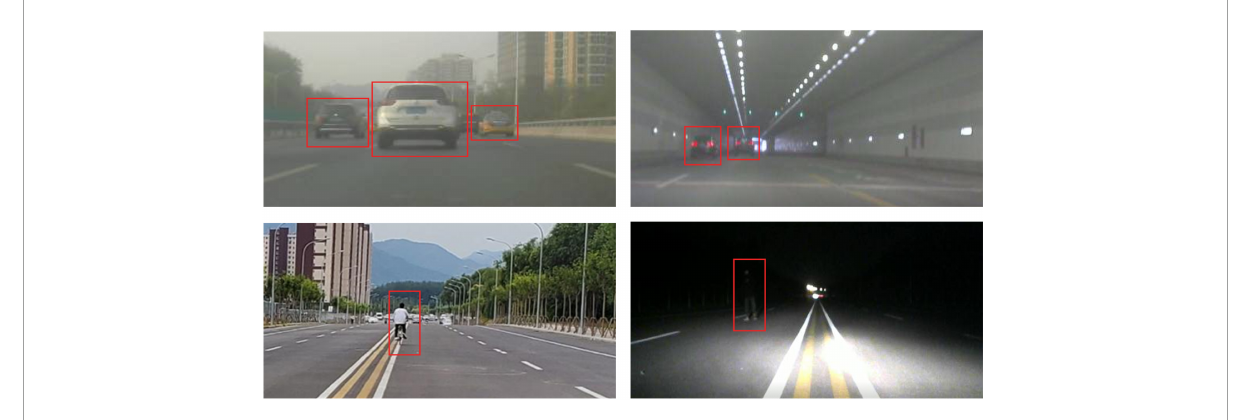
FIGURE7 Samples of different data collection scenarios.